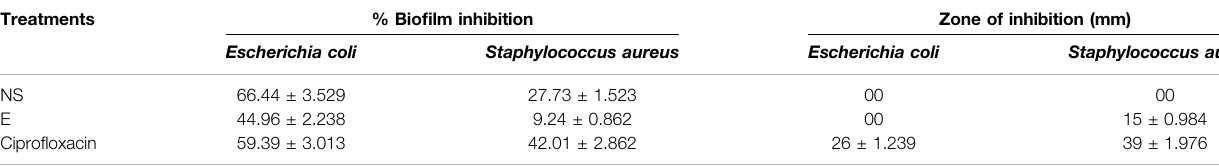
TABLE 3 | Antibacterial activity of N. sativa extract and nanosuspension against Escherichia coli and Staphylococcus aureus isolates. Treatments